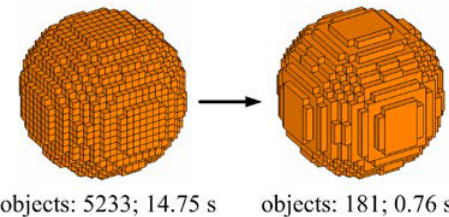
Fig. 5. Decomposition of a voxelized ball .